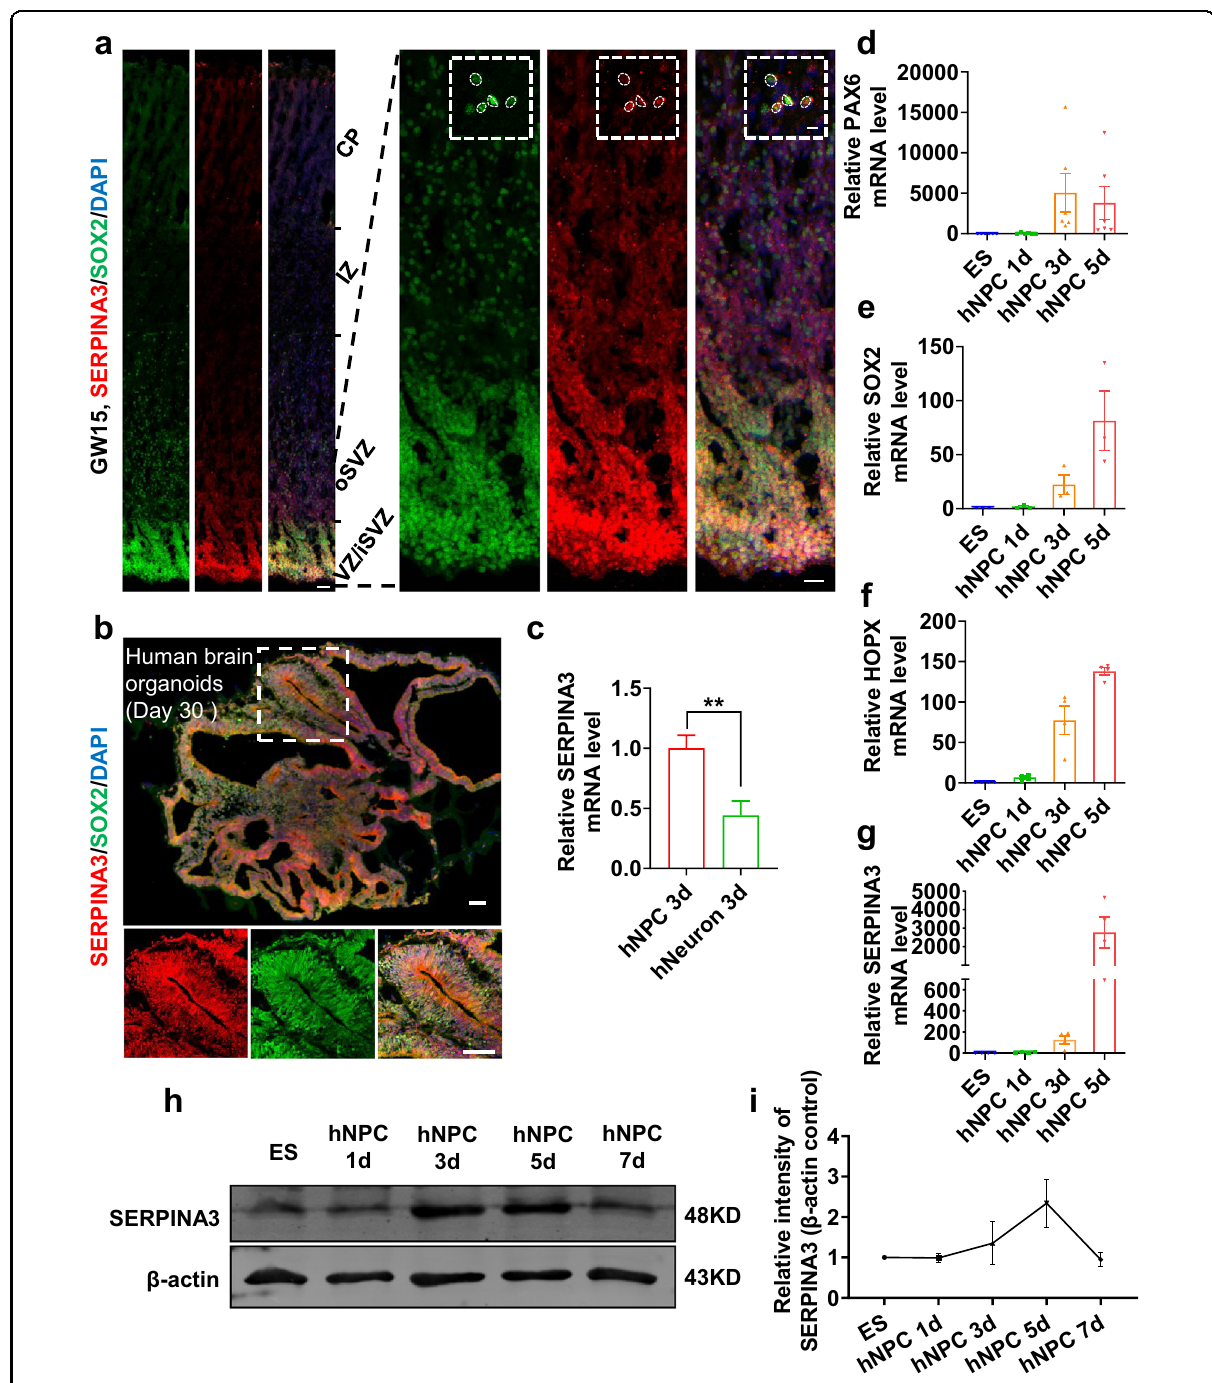
Fig. 1 SERPINA3 is expressed in VZ/SVZ of human brain. a IF for SERPINA3 and SOX2 in GW15 human brain. Dashed square showed the enlarged part. Scale bars, 50 μ m (left), 20 μ m (bottom right) and 5 μ m (top right). b IF for SERPINA3 and SOX2 in 30 days of brain organoids. Dashed square showed the enlarged part. Scale bars, 100 μ m. c RT-qPCR was performed to detect the mRNA level of SERPINA3 in hNPCs and neurons cultured in vitro ( n = 6). d – g RT-qPCR was performed to detect the relative mRNA level of PAX6 ( n = 6), SOX2 ( n = 3), HOPX ( n = 4) and SERPINA3 ( n = 4) in human ES cells and hNPCs cultured in vitro. h Western-blot analysis for the expression of SERPINA3 in human ES cells and cultured hNPCs in different time from day 1 to day 7. β -actin was detected as loading control. i Statistics of relative intensity of SERPINA3 ( n = 3). Two-tail unpaired t -test is used to analyze the data. n.s. no signi fi cant difference; P < 0.05 (*), P < 0.01 (**), P < 0.001